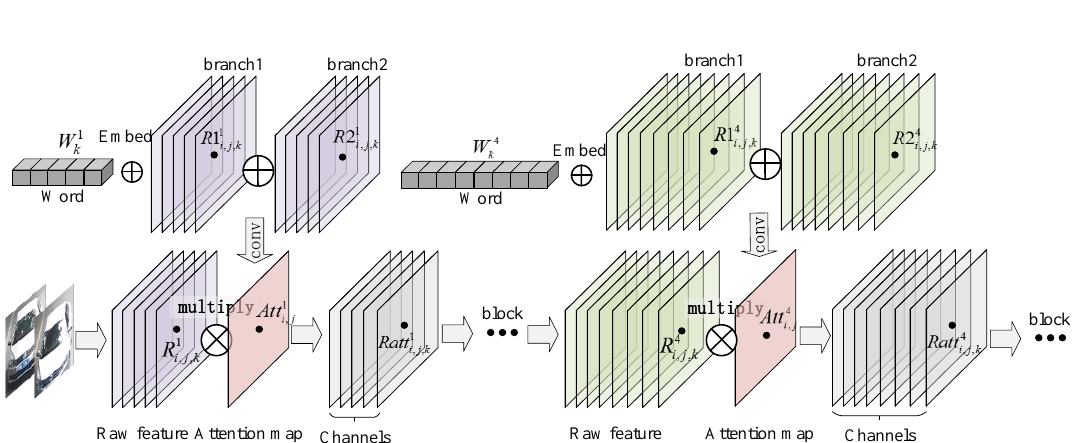
Figure 4. Architecture of multiresolution attention model. A word vector is embedded in the fused features of two branches for the generation of the shared attention map. Then, soft attention is implemented for both branches with the shared attention map. The same process is performed after each block.